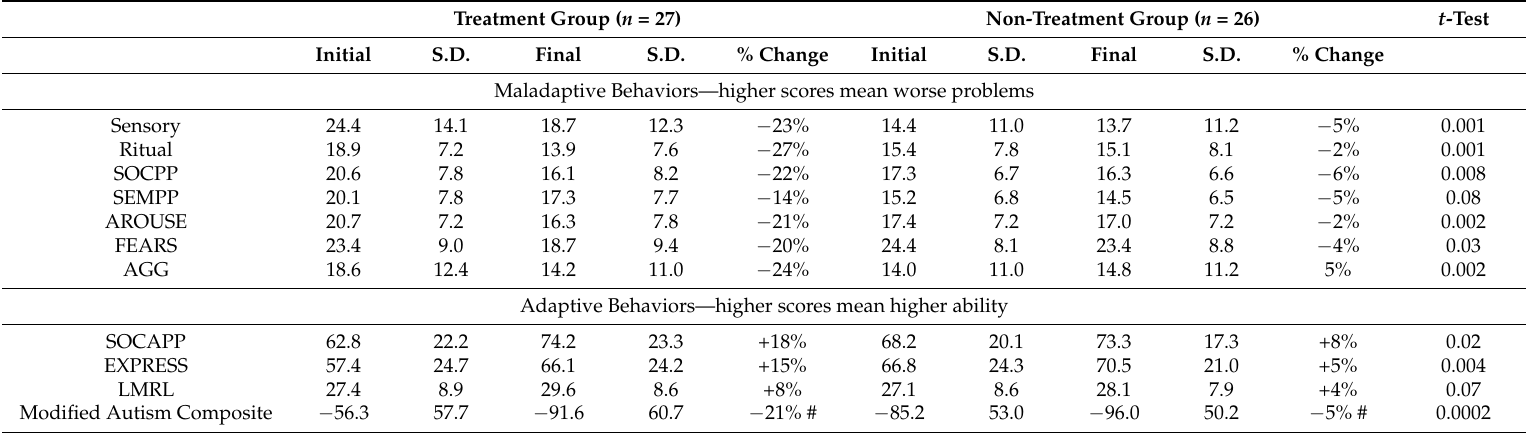
Table 6. Pervasive Developmental Disorders Behavior Inventory (PDD-BI).